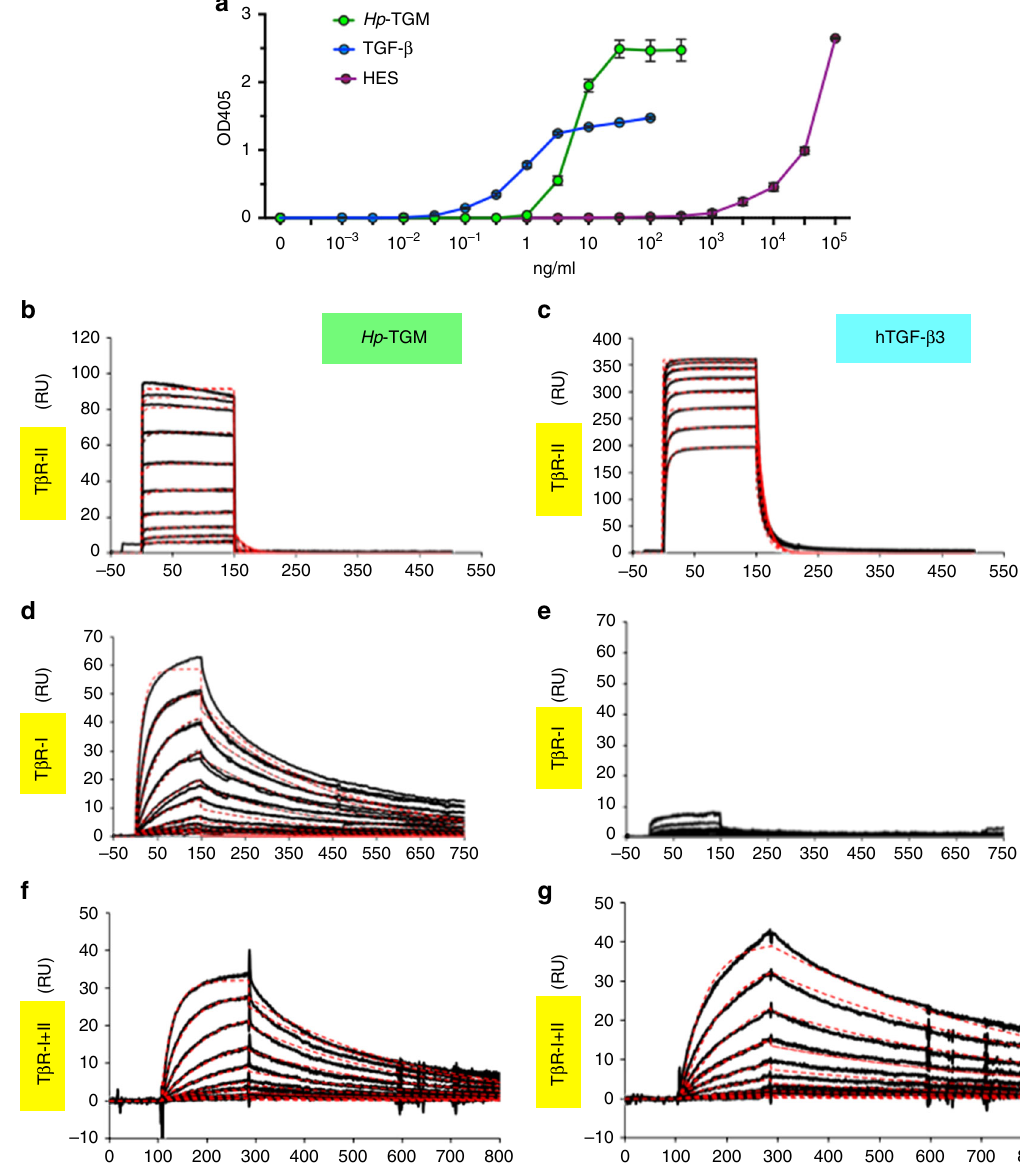
Fig. 2 Binding of Hp- TGM to the TGF- β Receptors. a MFB-F11 TGF- β -responsive bioassay for activity following 24 h of culture at 37 °C, comparing Hp- TGM to hTGF- β 1 and the complex HES mixture by protein concentration. MFB-F11 cells are transfected with a Smad-responsive plasmid construct in which TGF- β binding leads, through Smad phosphorylation and nuclear translocation, to expression of alkaline phosphatase, which is measured following the addition of p -nitrophenyl phosphate. Data shown are representative of > 3 independent experiments, and represent mean ± SEM from duplicate wells. b – e Surface plasmon resonance analysis of Hp- TGM and hTGF- β 3 binding to hTGF- β receptors. Streptavidin-coated biosensor chips were loaded with biotinylated Hp -TGM or hTGF- β 3 and two-fold dilutions of the ectodomain of hT β RII (from 13 µ M downwards) b , c and of the ectodomain of hT β RI (from 4 µ M downwards) d , e were passed over the Hp -TGM or hTGF- β 3 surface, respectively. Data shown are from one of two similar experiments. f , g Surface plasmon resonance analysis of Hp- TGM and hTGF- β 3 binding to T β RI in the presence of near-saturating T β RII (2 μ M), showing independent binding by Hp- TGM to both receptors, but binding of hTGF- β 3 to T β RI dependent on the presence of T β